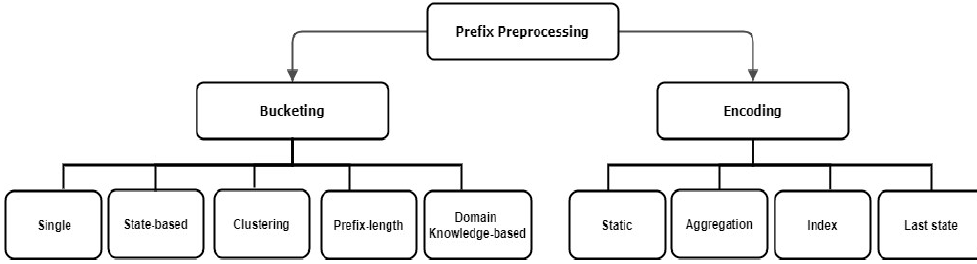
Figure 2. Preprocessing configurations (adopted from